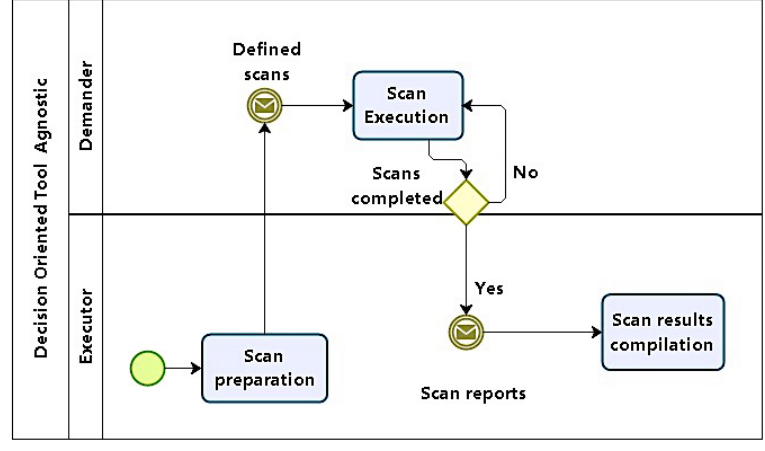
Figure 3. Phase 2: Initial